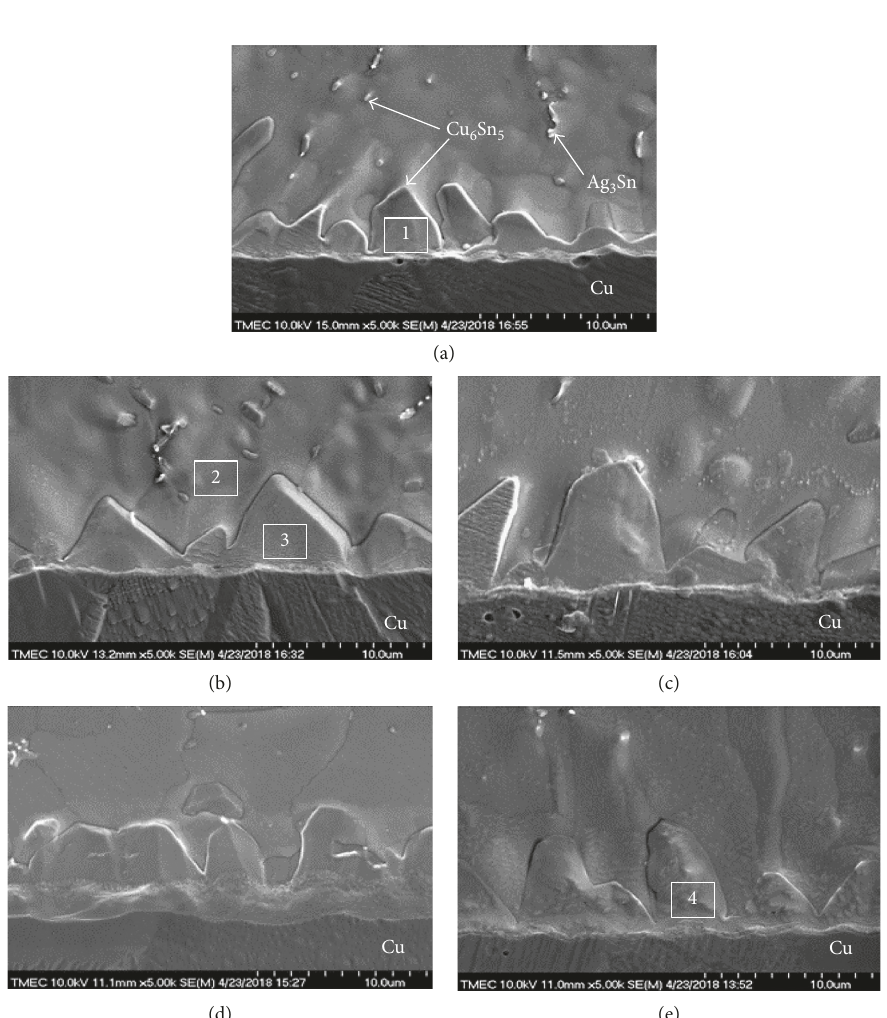
Figure 11: The intermetallic layer between the Cu substrate and (a) SAC0307, (b) SAC0307-0.25ZnO, (c) SAC0307-0.50ZnO, (d) SAC0307- 0.75ZnO, and (e)